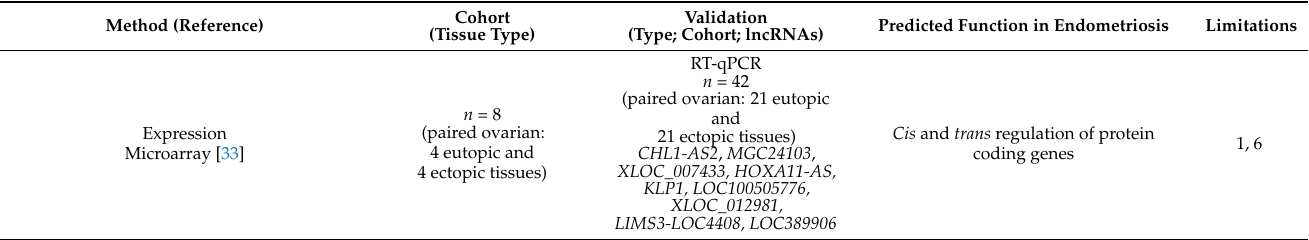
Table 1. Genome-wide studies that identified differentially expressed lncRNAs in endometriosis. Method (Reference) Cohort (Tissue Type) Validation (Type; Cohort; lncRNAs) Predicted Function in Endometriosis Limitations